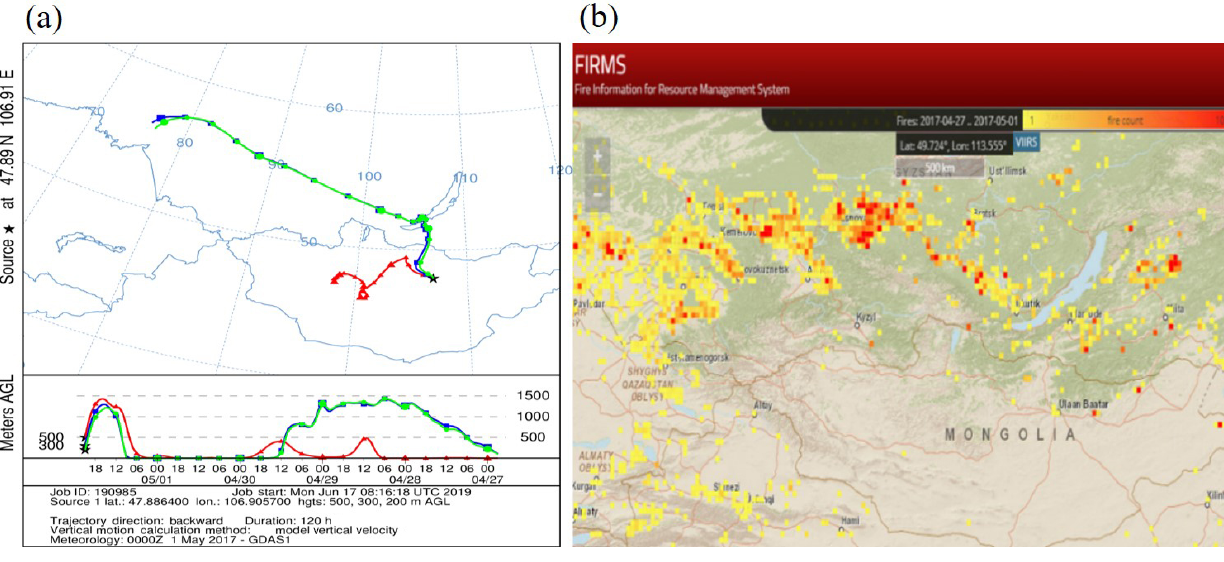
Figure 6. (a) The 5-day backward air-mass trajectories (https://ready.arl.noaa.gov/HYSPLIT.php, last access: 17 August 2019) and (b) FIRMS fire counts (https://firms.modaps.eosdis.nasa.gov/alerts/, last access: 17 August 2019) around Ulaanbaatar during spring of